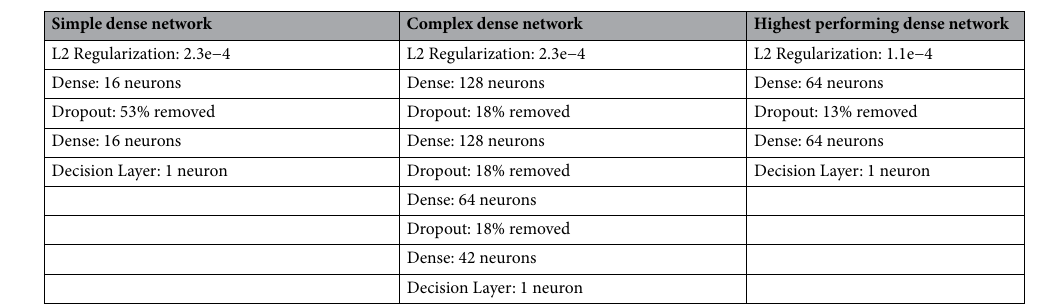
Table 1. Examples of DFNN network architectures tested in the random search. Hyperparameters shown include the regularization coefficient, number of layers, number of neurons per layer, and dropout fraction. Left column illustrates a simple network with fewer and smaller layers. Middle shows a complex network with more, larger layers. Right column shows the architecture of the highest performing network.